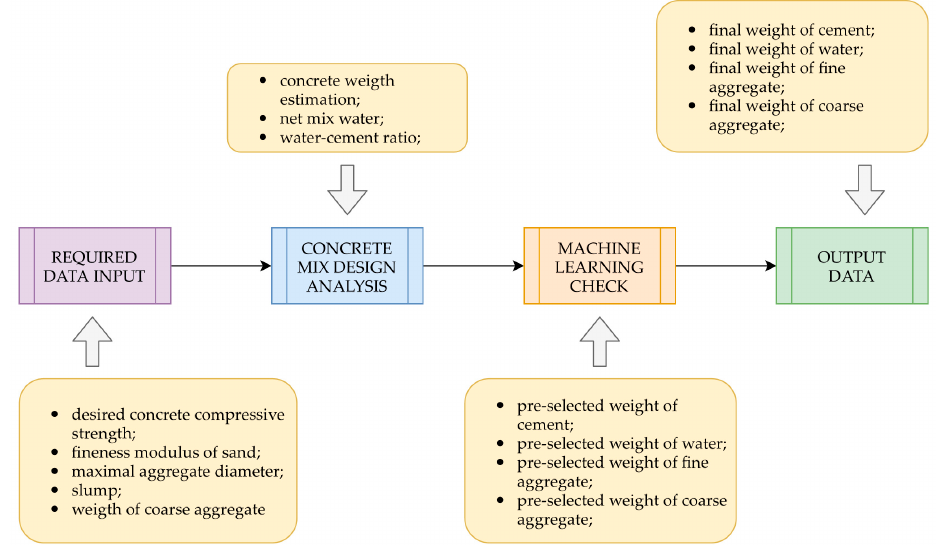
Figure 1. Block diagram of the practical application of machine learning in the concrete mix design.